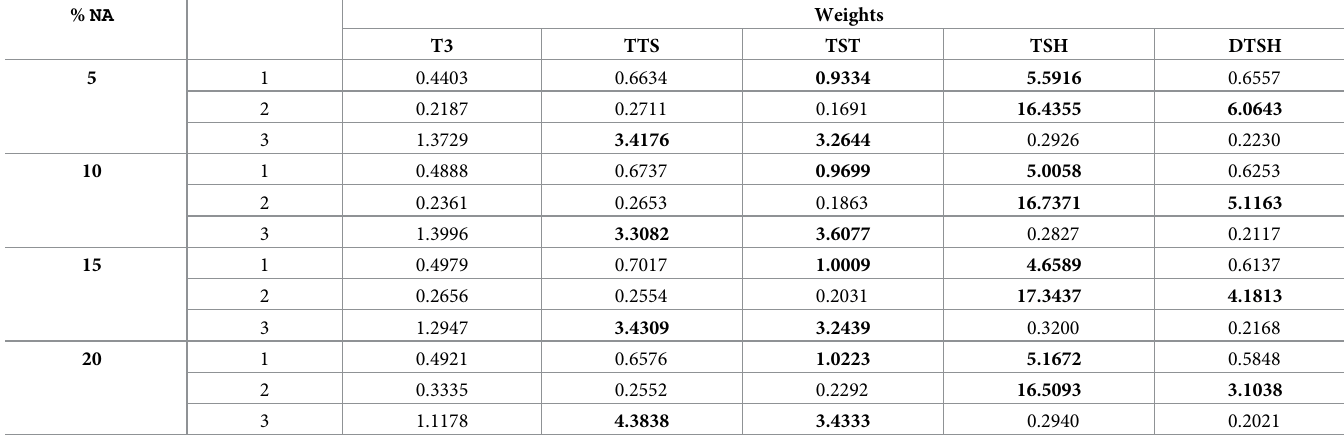
Table 11. Weights of the variables in each group found by the VKFCM-K-LP algorithm with the OCS strategy under different percentages of missing values.